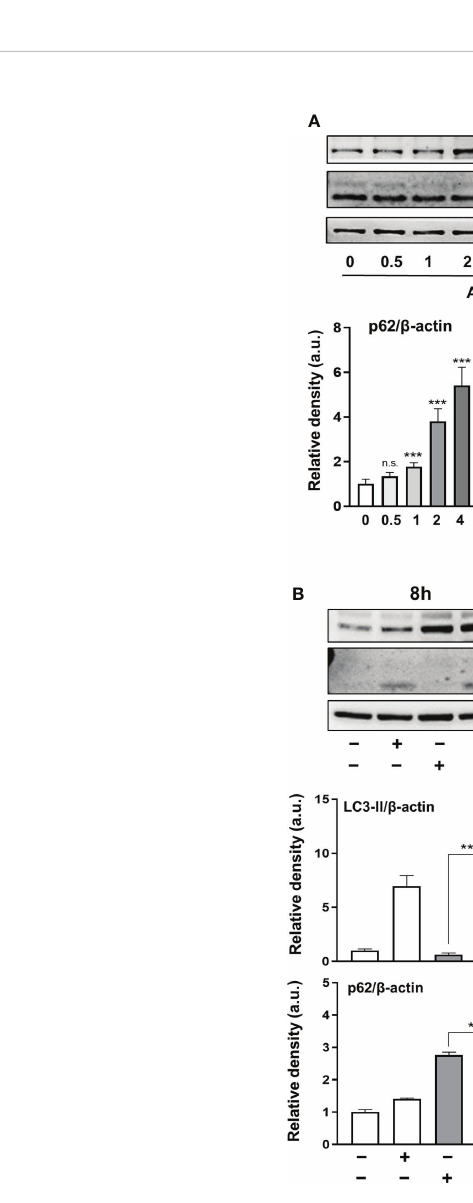
FIGURE 3 AcpM has no effect on autophagic fl ux in macrophages. (A) BMDMs were treated with recombinant AcpM (10 m g/ml) for the indicated times and the cell lysates were subjected to immunoblot analysis. One representative image (upper panel) and the densitometric analysis of the protein bands (lower panel) were presented. (B) BMDMs were pretreated with or without Baf-A1 (50 nM) for 1 h and then followed by AcpM (10 m g/ml) treatment. After 8h or 24 h, cells were harvested and subjected to immunoblot analysis with cell lysates. One representative image (upper panel) and the densitometric analysis (lower panel) of immunoblots were presented. Statistical analysis was determined with an one-way ANOVA and presented as means ± SD from at least three independent experiments performed. * p < 0.05; *** p < 0.001. a.u., arbitrary unit; n.s., not signi fi